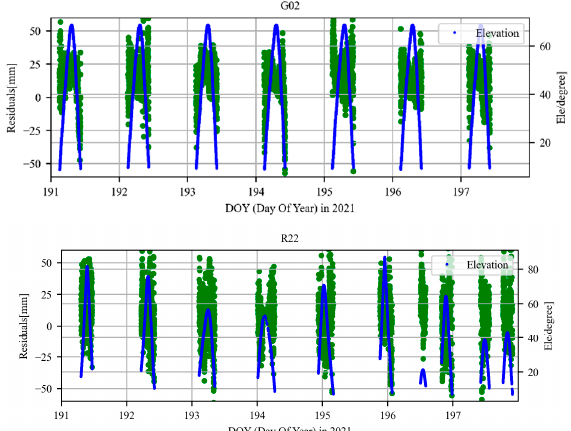
Figure 11. Time variations of residuals with respect to the elevation for station HAHB.